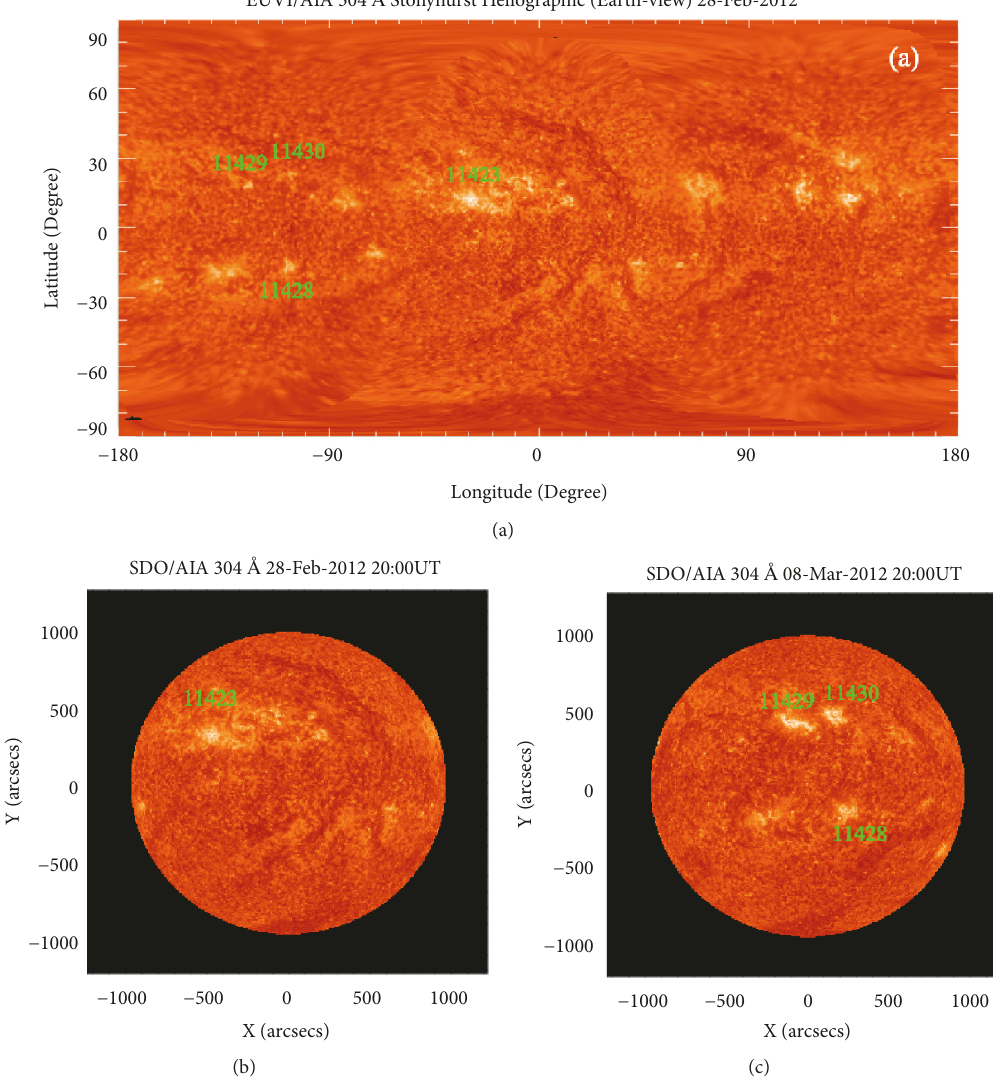
Figure 12: The 304 ˚A full-disk EUV images on 28 February 2012 (a) and Earth-side EUV images on 28 February 2012 (b) and 8 March 2012